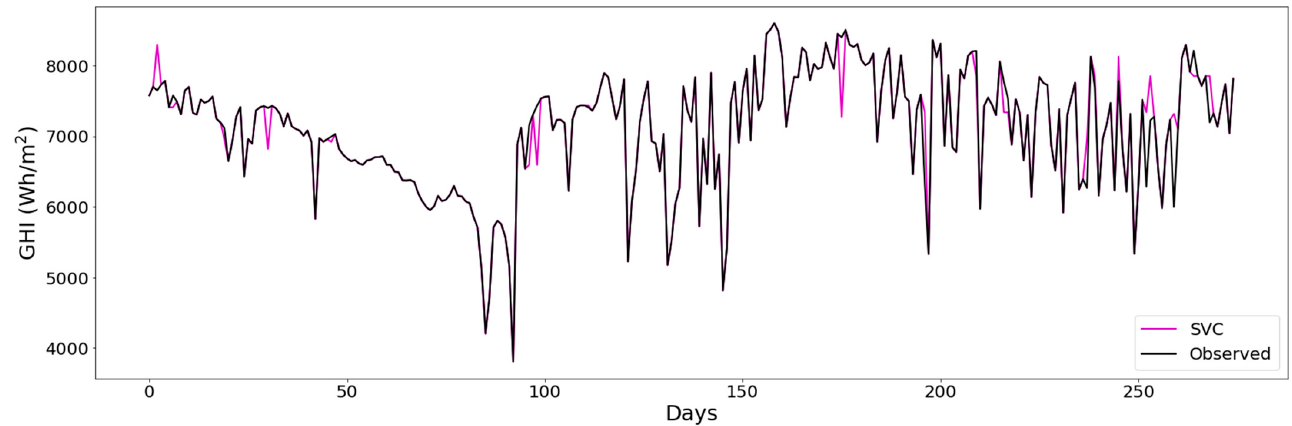
Figure 15. Graphical representation of SVC predictions.